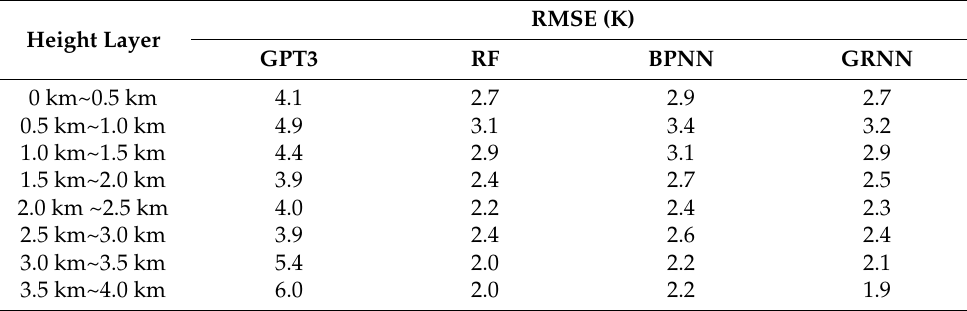
Table 3. Root mean square errors of different models at different height